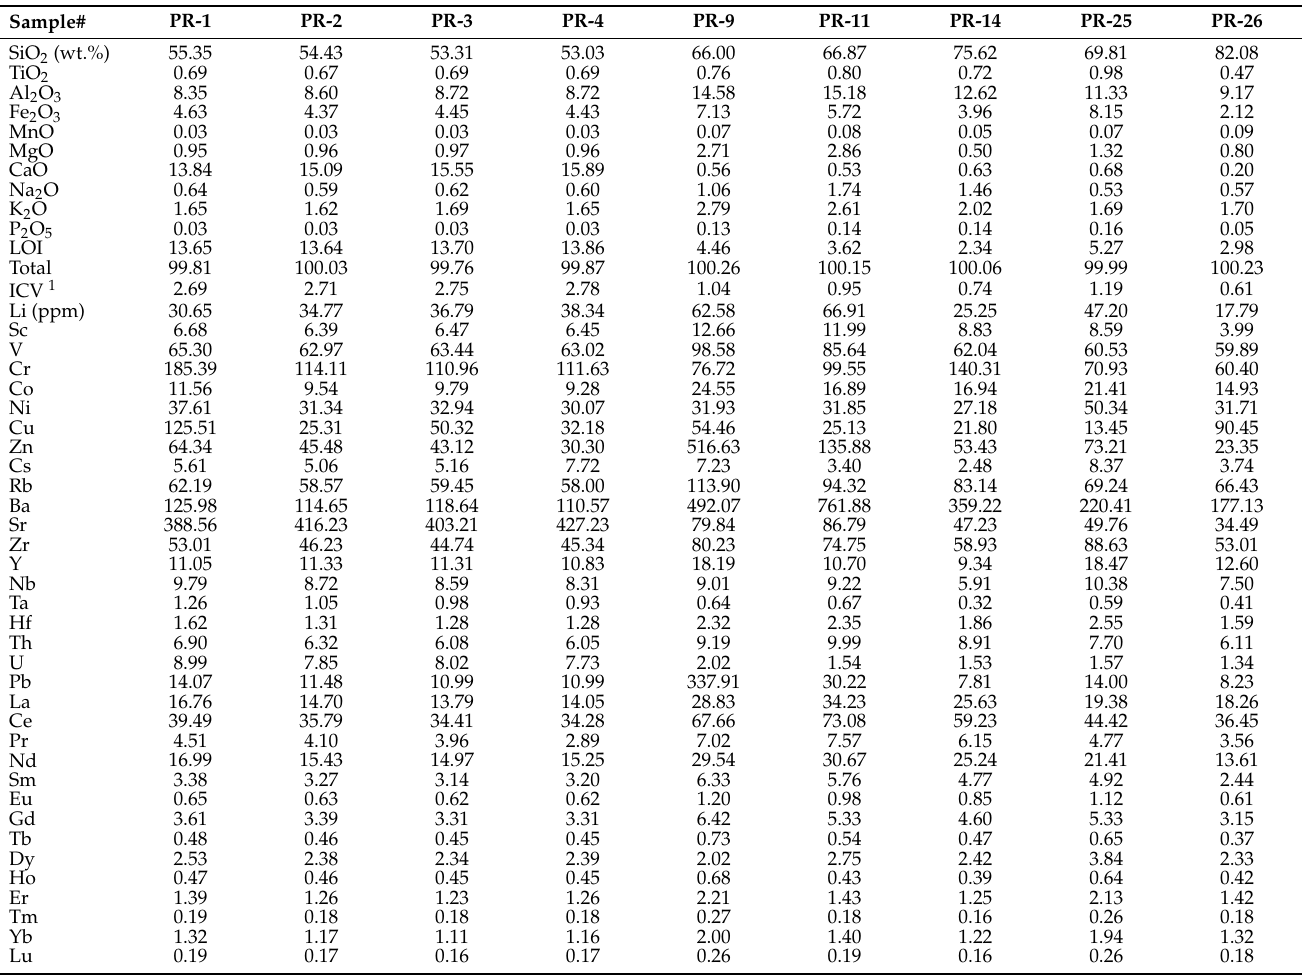
Table 1. Chemical composition of Paleozoic black shale from the Priorat DOQ region